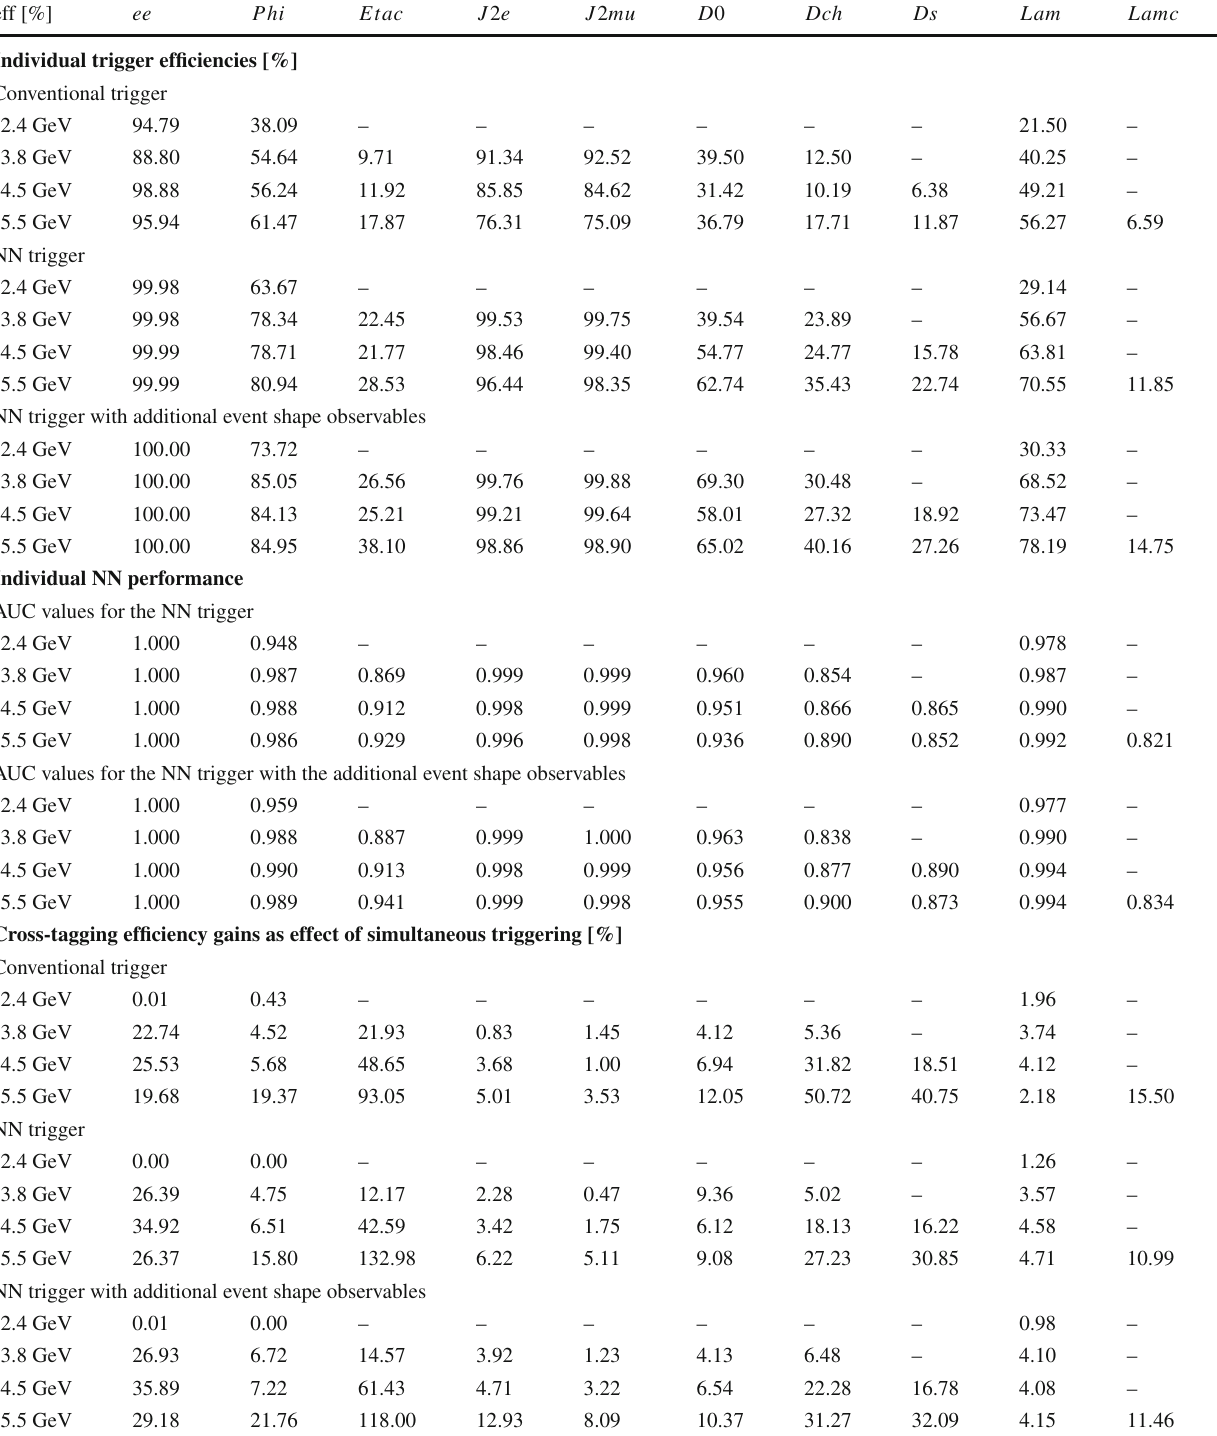
Table 6 Collection of individual trigger efficiency results for a target 1/1000 background suppression, the AUC values of the ROC curves as well as the simultaneous trigger efficiency gains for all accessible channels eff [%] ee Phi